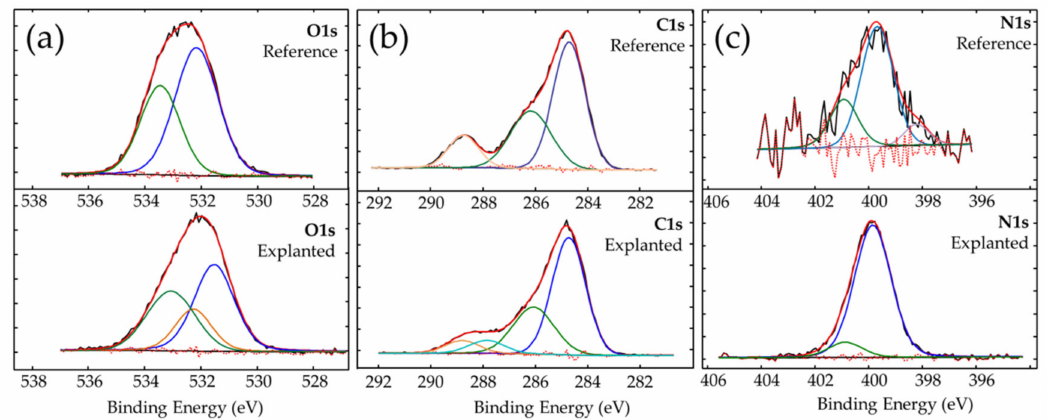
Figure 6. High resolution photoemission spectra of ( a ) oxygen O1s, ( b ) carbon C1s, and ( c ) nitrogen N1s for reference and explanted